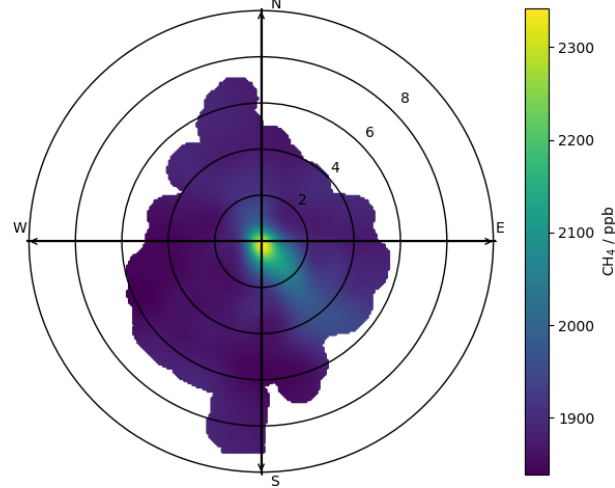
Figure 10. Polar bivariate plot showing the relationship between CH 4 , wind speed and wind direction over the full